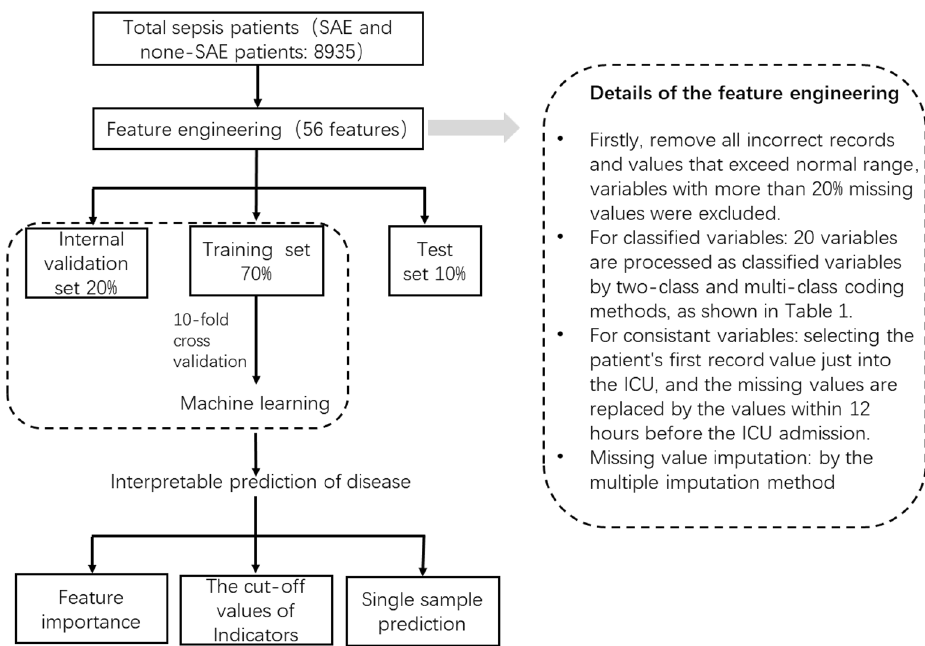
Figure 2. Research flow chart. Details of feature engineering and machine learning prediction